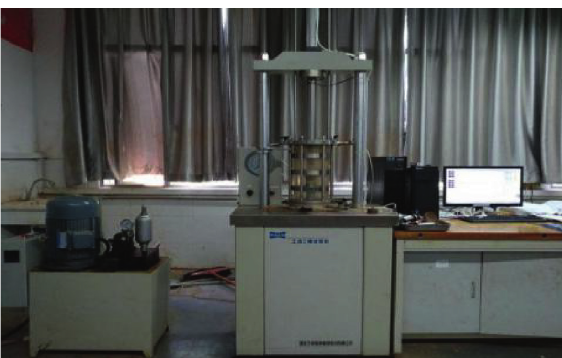
Figure 1: Soil triaxial testing machine.